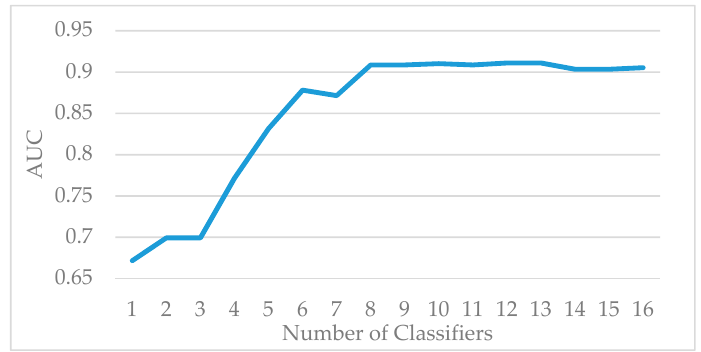
Figure 1. The AUC of AdaBoost Algorithm on Vehicle Training Set.